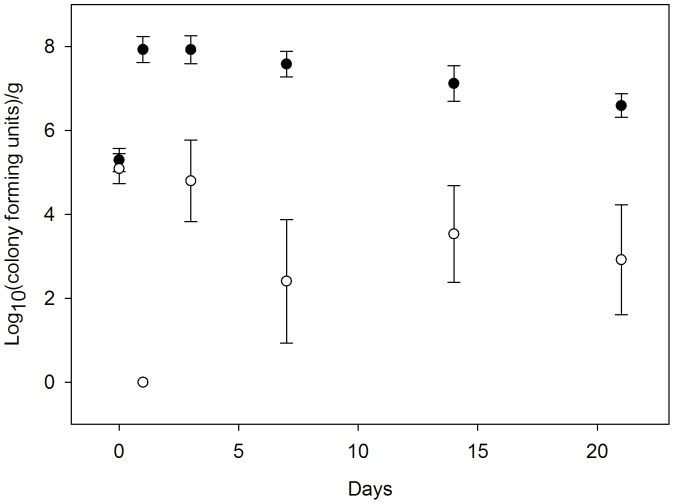
Ceftiofur metabolites confer selective advantage to cefR
E. coli by restricting cefS population in soil.Mean colony forming units for presumptively ceftiofur sensitive (cefS) fecal E. coli in a matrix of sandy soil and feces (25∶1) after addition of urine containing 0 ppm (open circles) or 50 ppm (closed circles) CFM and incubated at 23°C. Bars = s.e.m.